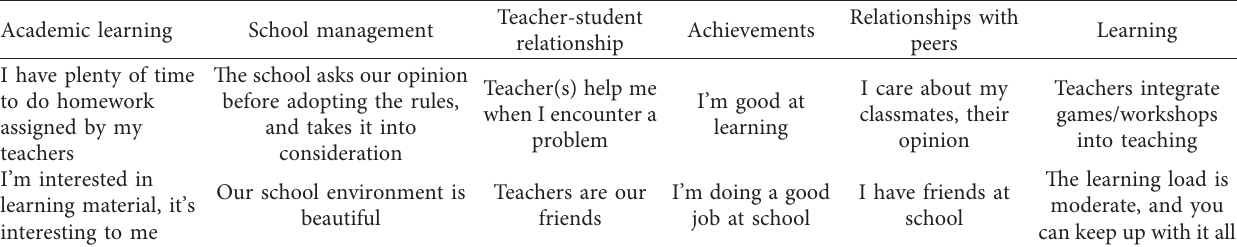
Table 3: Example of the quality-of-life scale for primary school pupils (according to